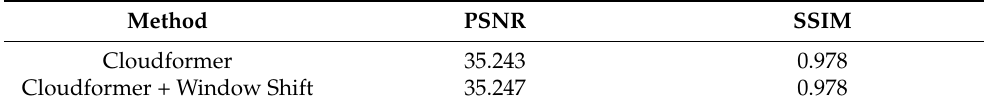
Table 2. Quantitative results of Cloudformer with and without window shift on the RICE1 test